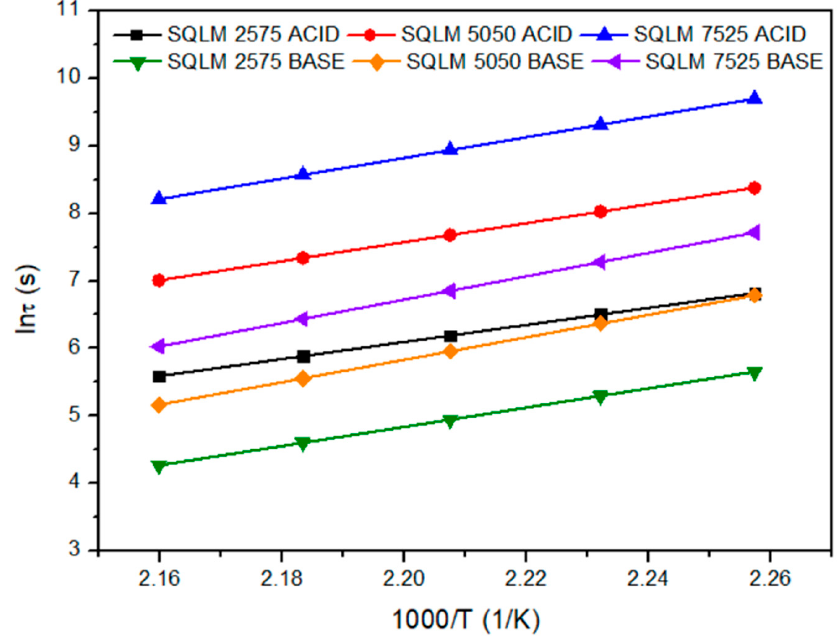
Figure 7. Arrhenius plot of relaxation times against temperature for all the materials prepared, measured from the stress relaxation experiments.